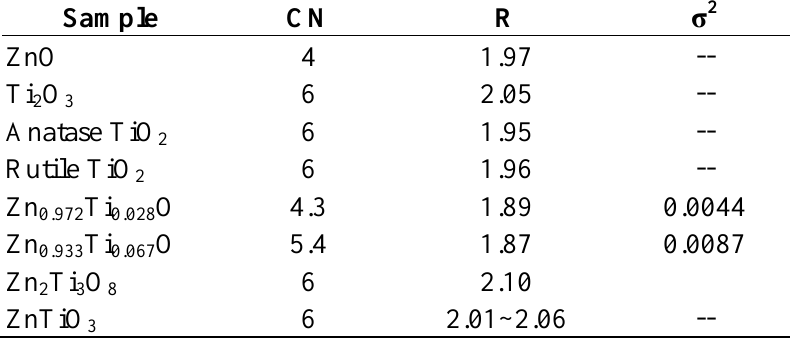
Table 2. Structural parameters of references from the literatures and results of the data fit of the Ti-O or Zn-O(ZnO) shell in Zn CN = coordination number; R (Å) = bond length; and σ 2 (Å 2 ) = Debye-Waller factor. The uncertainties are 10%, 0.02 Å, and 10%,